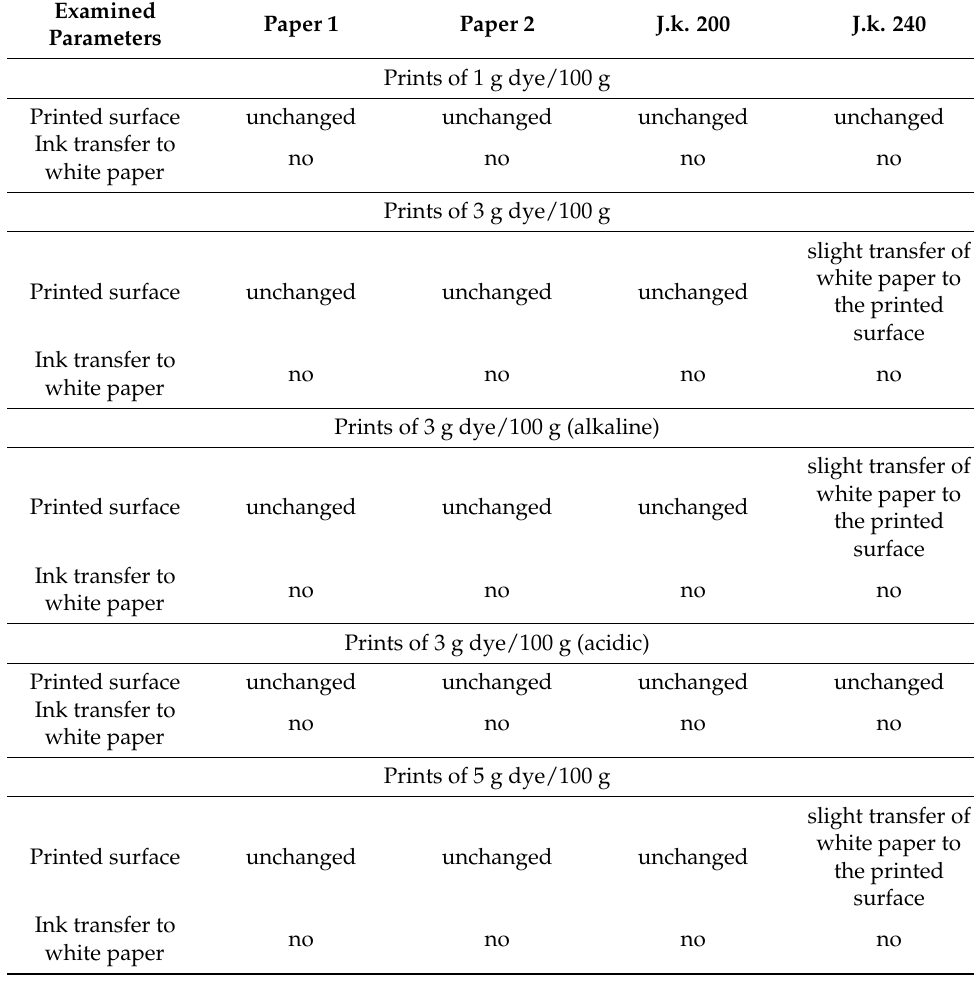
Table 3. Colorfastness of prints on papers to dry